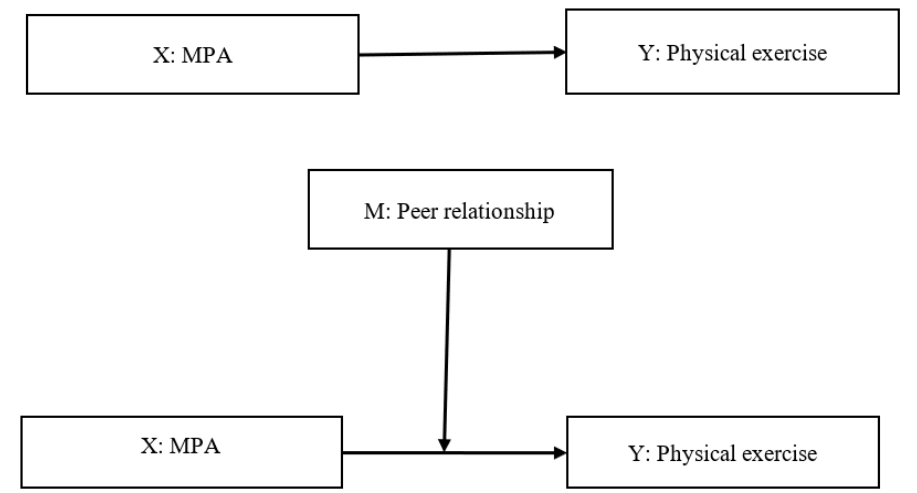
Figure 1. Conceptual model of this